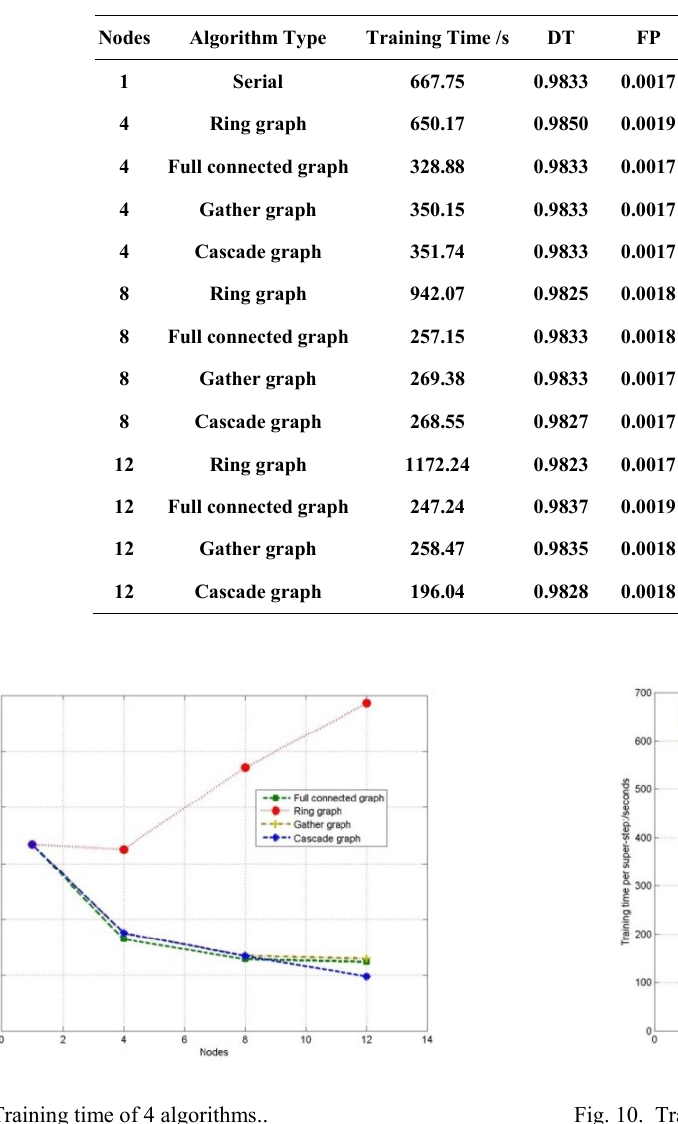
Table 2. Performances of training set Dataset s:/seconds